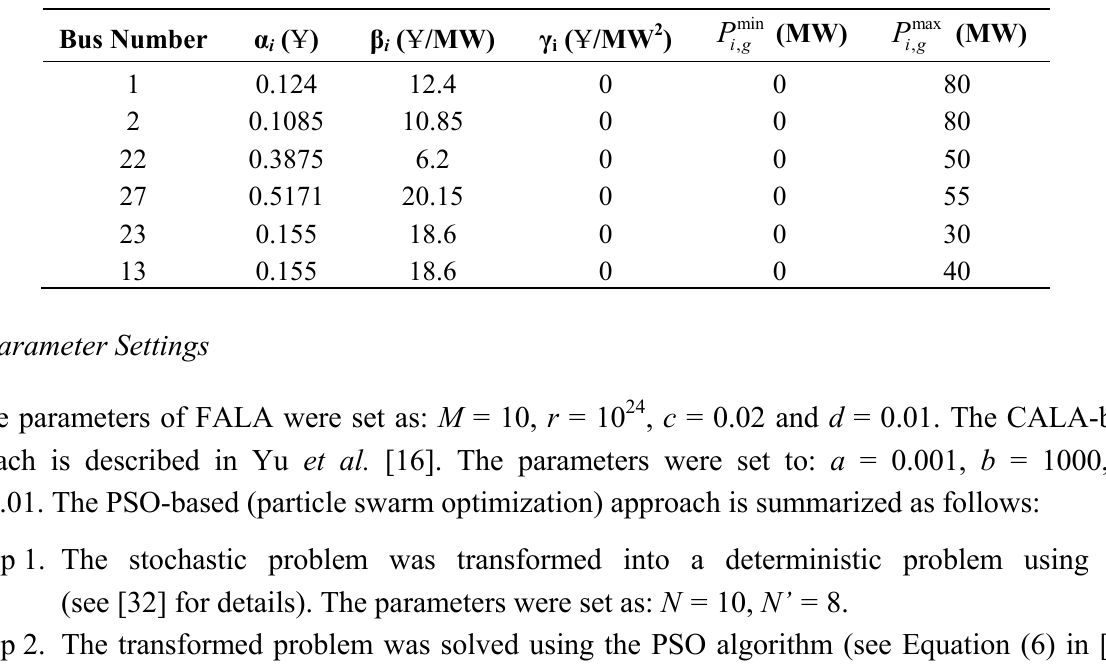
Table 1. Parameters of conventional